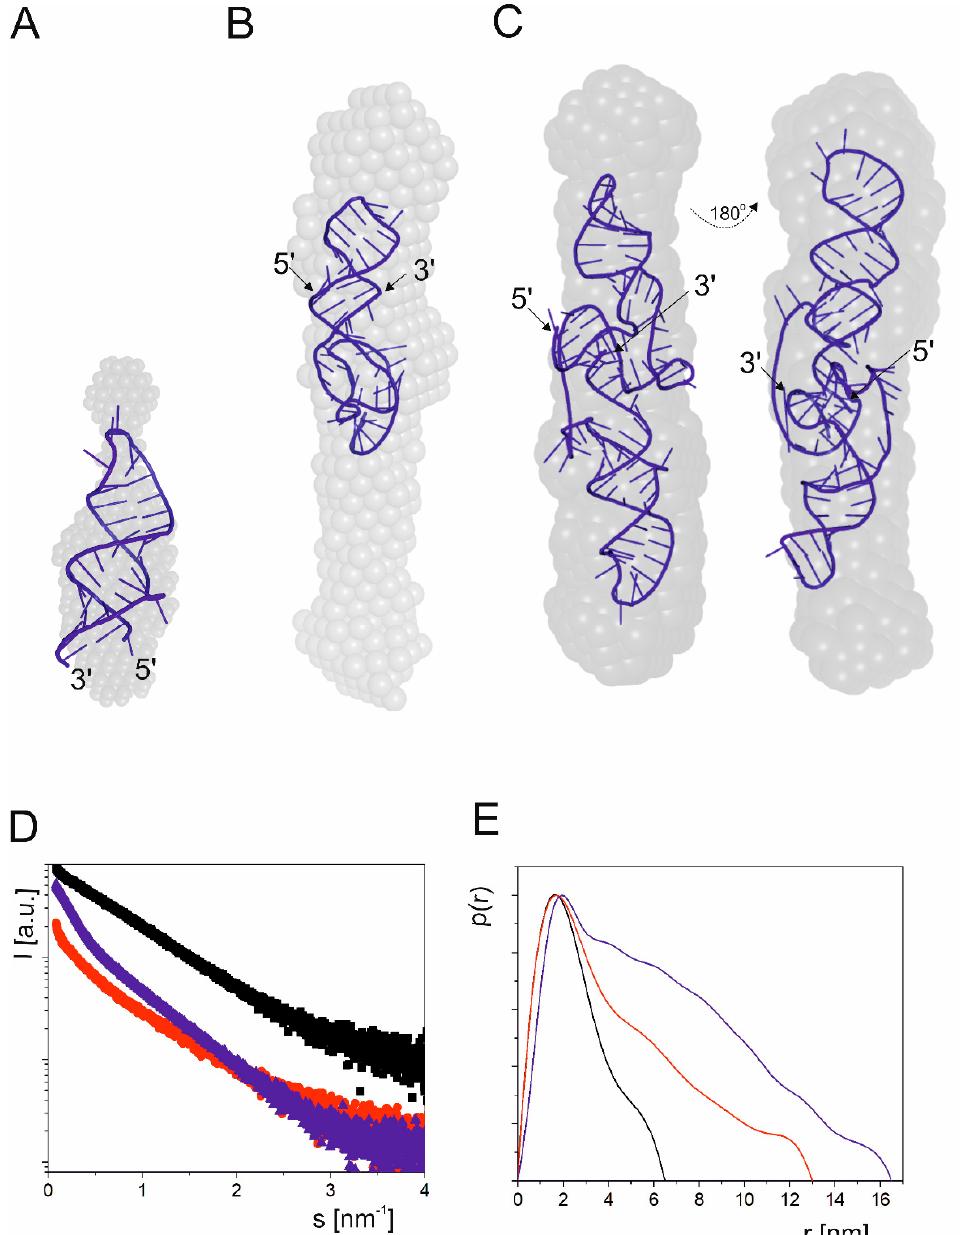
Figure 3. Structural analysis of mRNA fragments: RNA47/81 ( A ), RNA89/140 ( B ) and RNA47/140 ( C ). SAXS-derived ab initio envelopes are superimposed with tertiary structures generated by the RNAComposer program. Experimental SAXS curves ( D ) and corresponding pair distance distribution functions ( E ) are shown for: RNA47/81—black, RNA89/140—red and RNA47/140—blue.